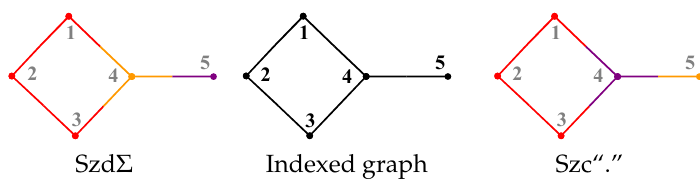
Figure 23. Same partition, different coloring of vertices for Figure 1 (see Table 9).